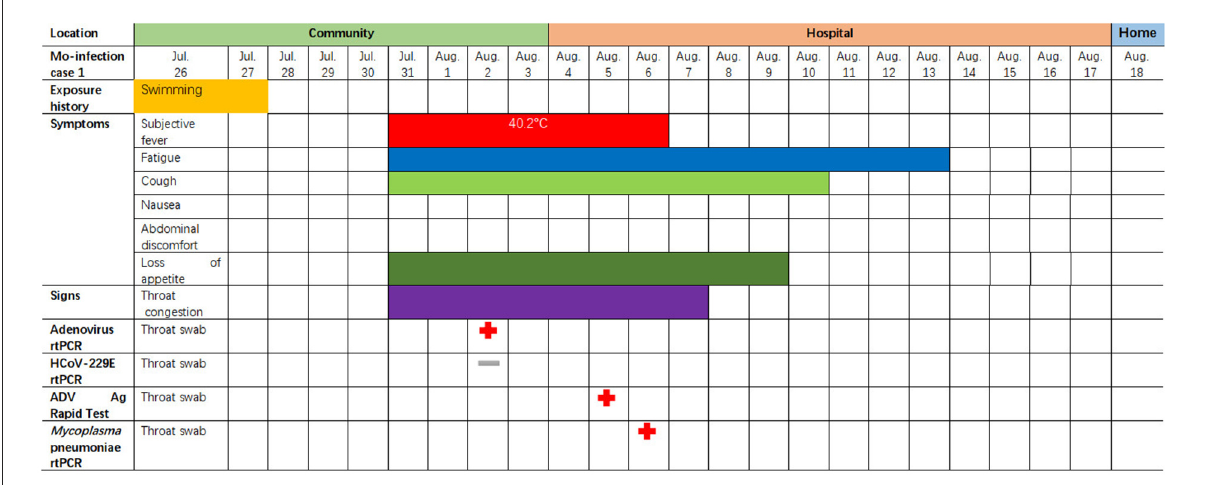
FIGURE4 Symptoms and results of rtPCR testing and antigen rapid test for a two-year-old child coinfected with adenovirus and single M. pneumoniae who was admitted to the pediatric ward in Lishui, Zhejiang Province, August 4–17, 2019. rtPCR = real-time PCR. ADV = adenovirus. The red cross indicates that the pathogen (adenovirus or single M. pneumoniae ) was detected by PCR or rapid antigen detection. The gray—indicates an HCoV-229E negative result.